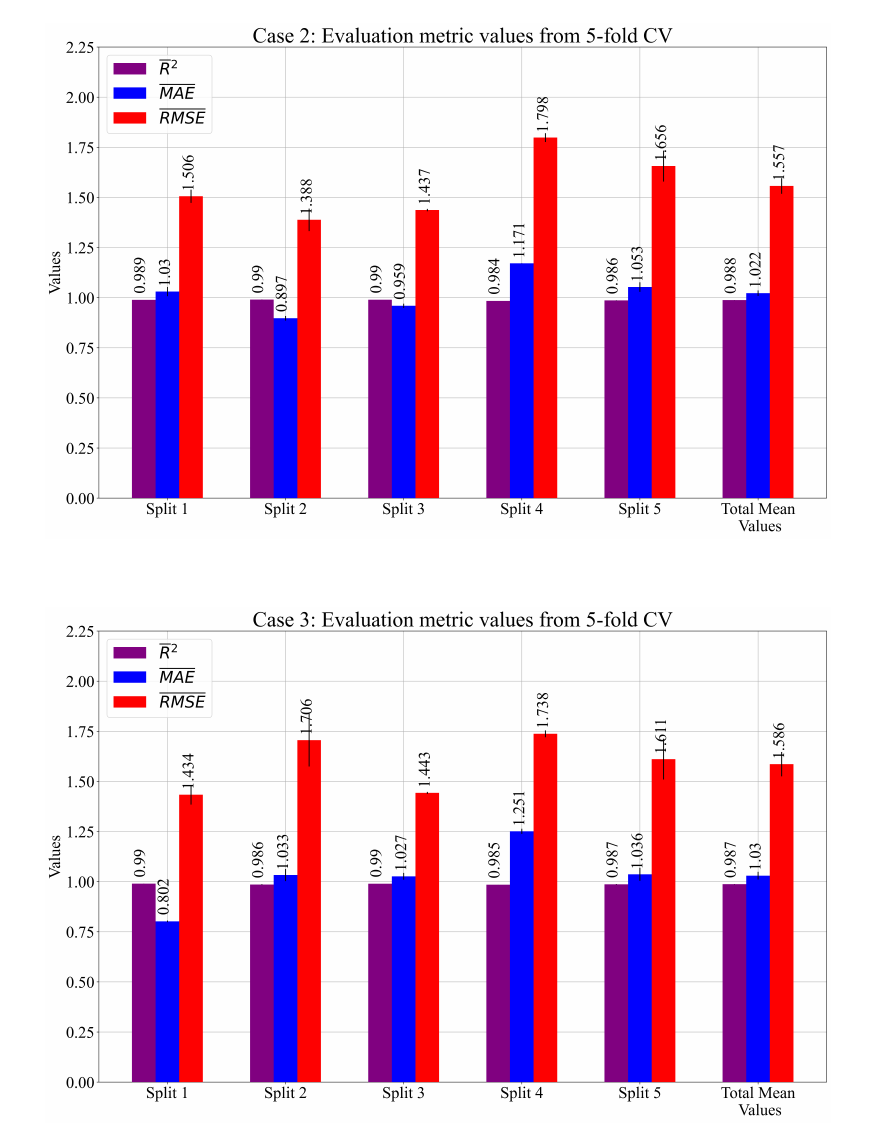
Figure 6. The mean values of the obtained performance metric during GPSR 5-CV. The σ values are presented as error